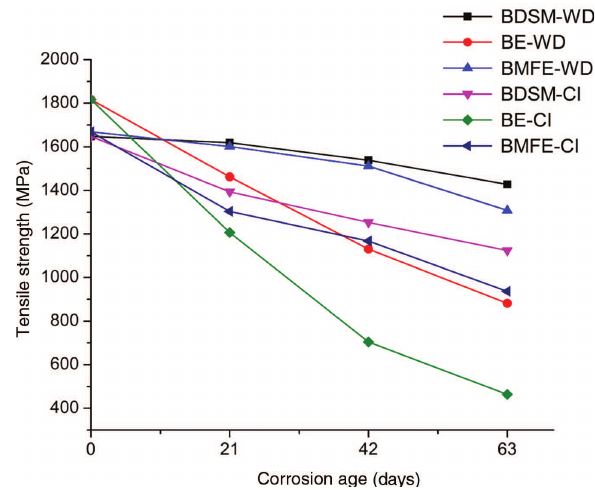
Figure 10: Tensile strength of different corrosion conditions versus corrosion age. Table 3: Fitted